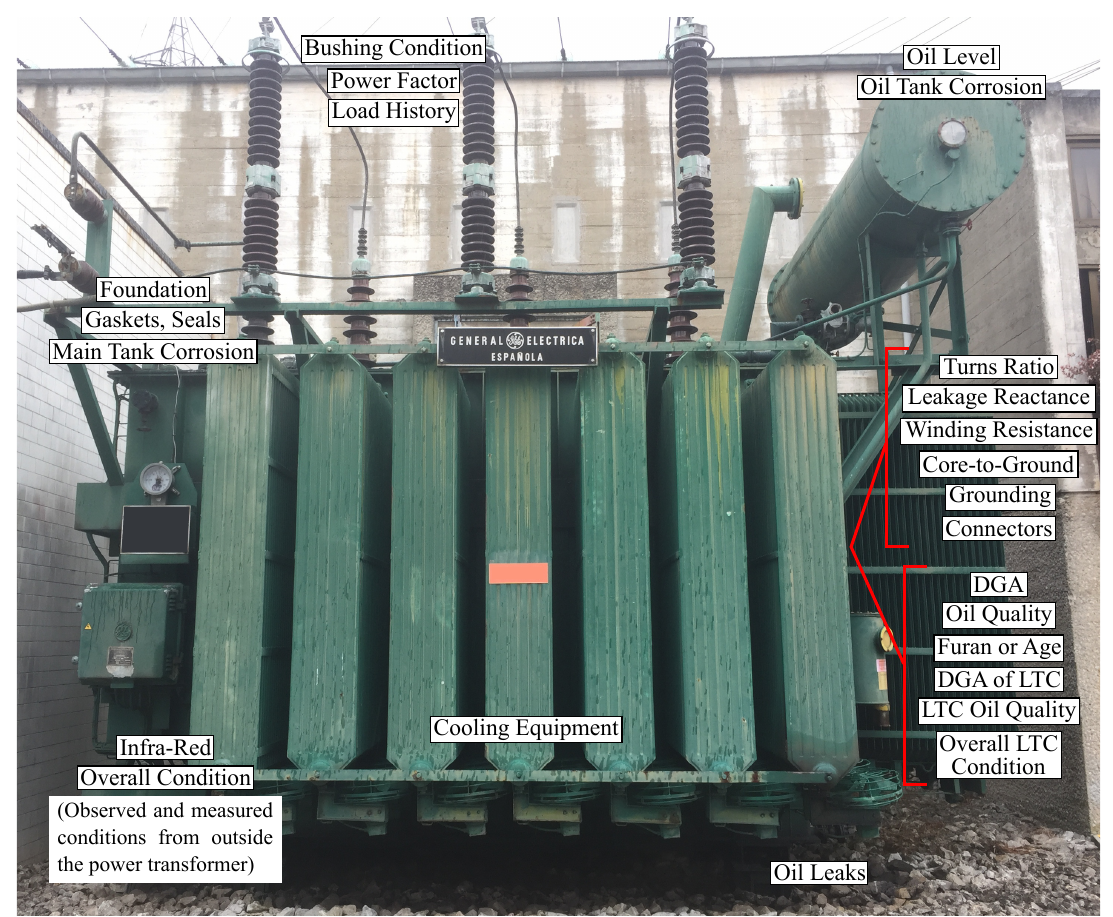
Figure 1. Locations of condition parameters used to calculate the HI of the